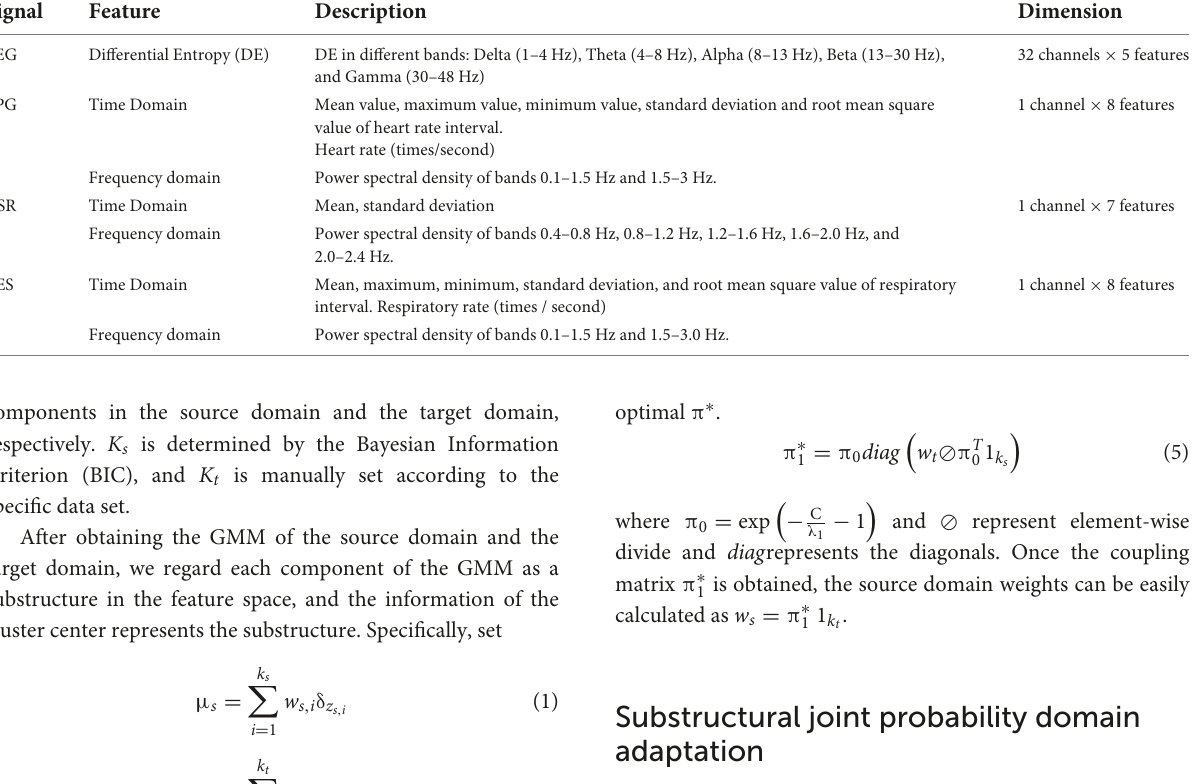
TABLE 1 The features used in Experiment 1 and Experiment